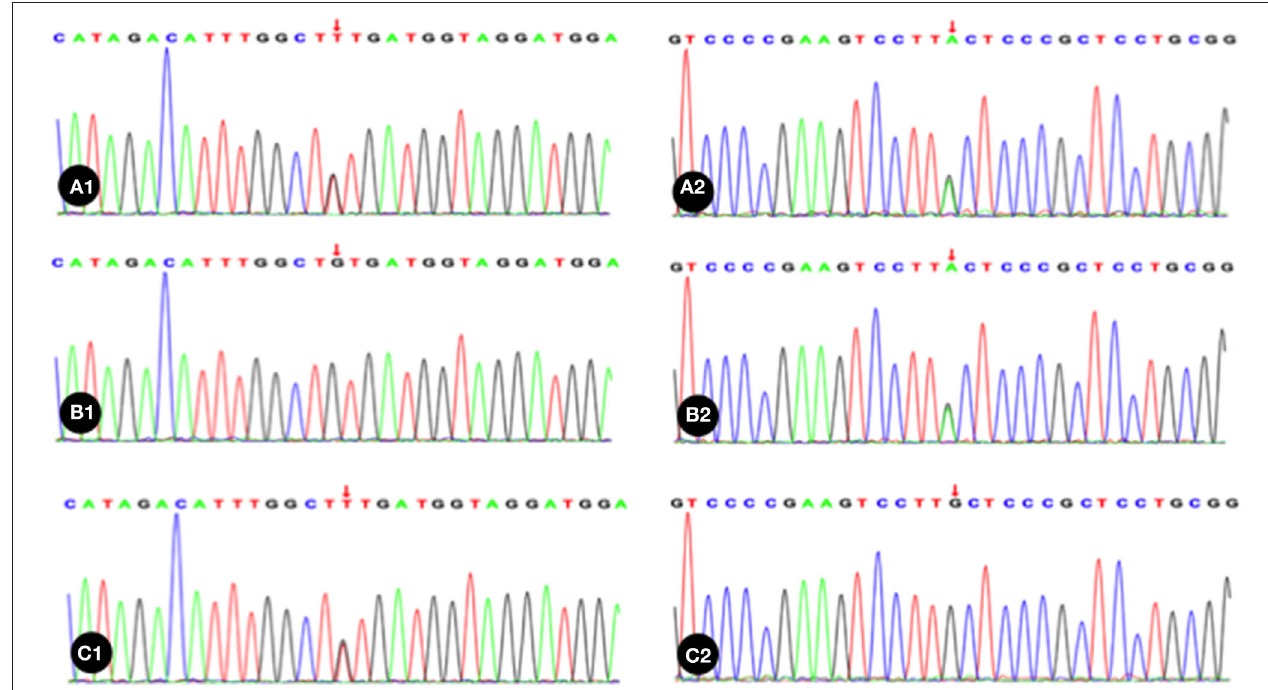
FIGURE 1 | The neonatal patient harbored a mutation of c.1595G > T in 1 allele; B1, Absence of mutation in the patient’s father; C1, The patient’s mother harbored a heterozygous mutation of c.1187G > A; A2, The neonatal patient harbored a mutation of c.1187G > A in 1 allele; B2, The patient’s father harbored a heterozygous mutation of c.1187G > A; C2, Absence of mutation in the patient’s mother. Red arrow indicates the nucleotide position of the mutation.